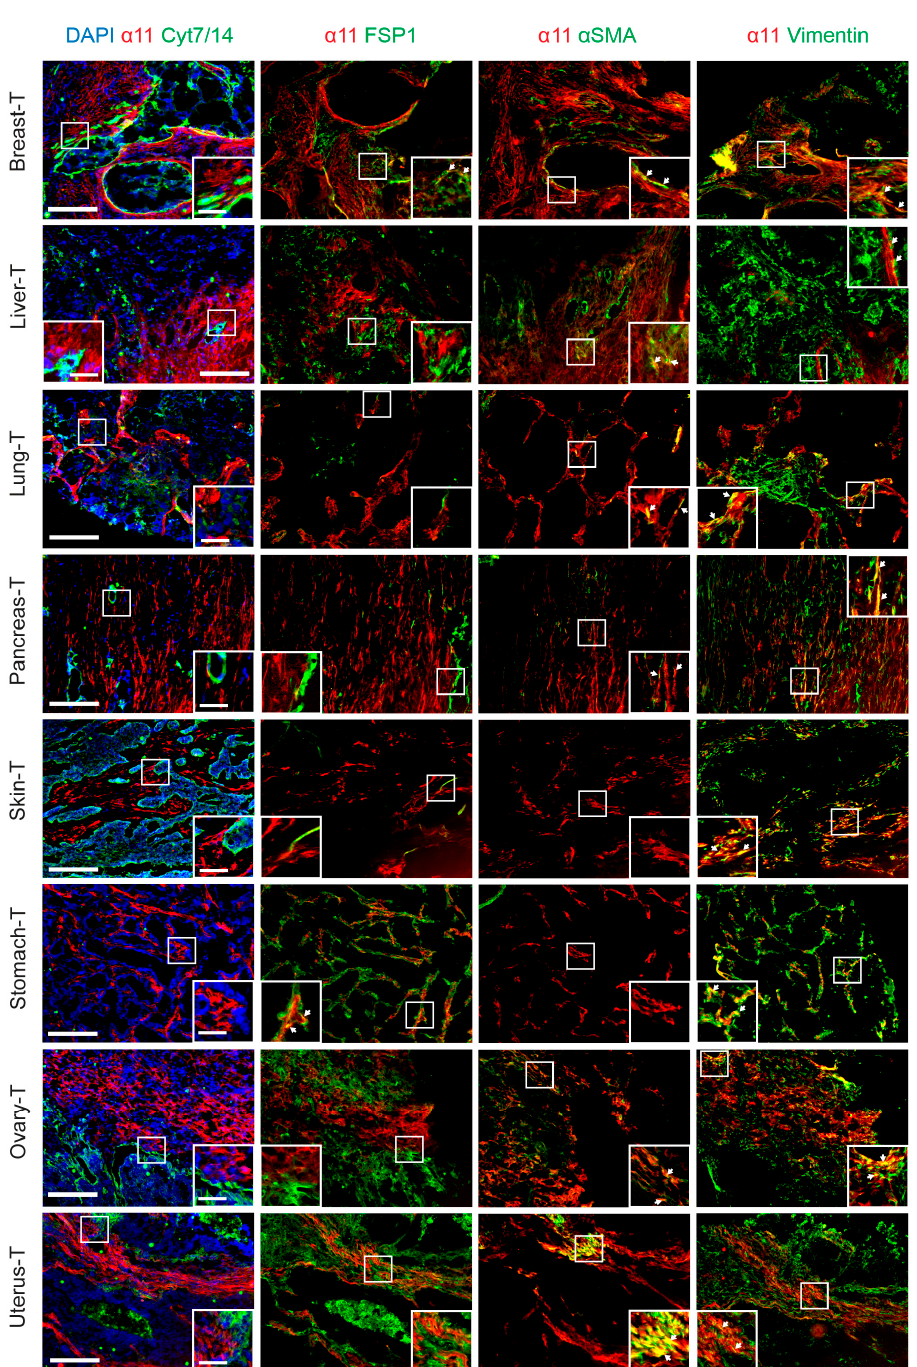
Figure 3. Integrin α 11 co-localization with various markers in selected tumor array sections. The sections were stained with α 11 203E3 mAb (red,) combined with cytokeratin 7 and 14 (green), FSP1 (green), α SMA (green), and vimentin (green), respectively, as indicated. DAPI (blue) was used for counterstaining only in the combination of integrin α 11 and cytokeratin 7 / 14. Pictures shown were taken under Zeiss Axioscope microscope (10 × ). Scale bar: 200 µ m.A close-up image of a region of interest is inserted in each picture (scale bar: 50 µ m). Arrows denote co-localization of integrin α 11 with other stroma markers.